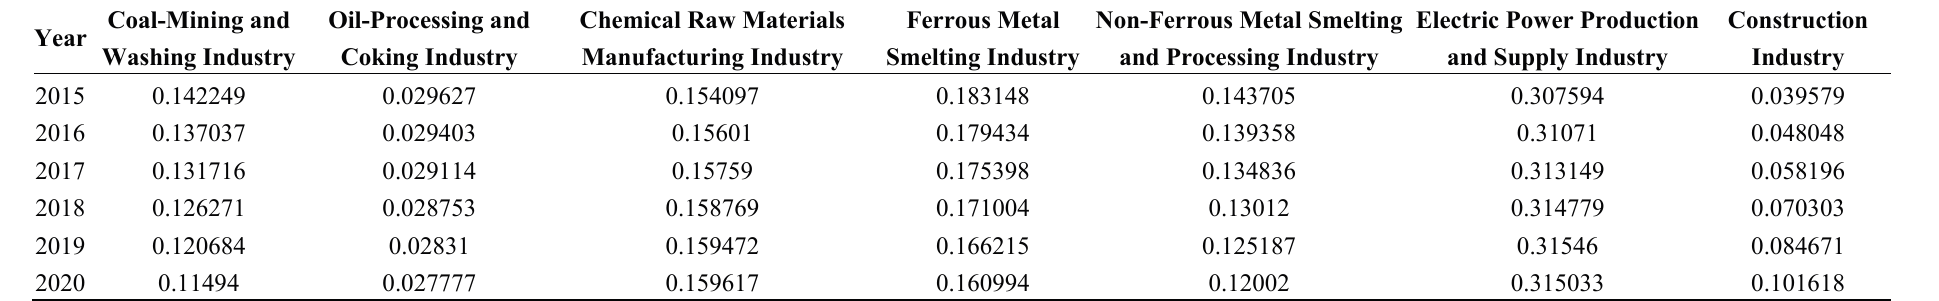
Table 21. Predicted values of the total CO 2 emissions per 10 thousand yuan (10 thousand tons).